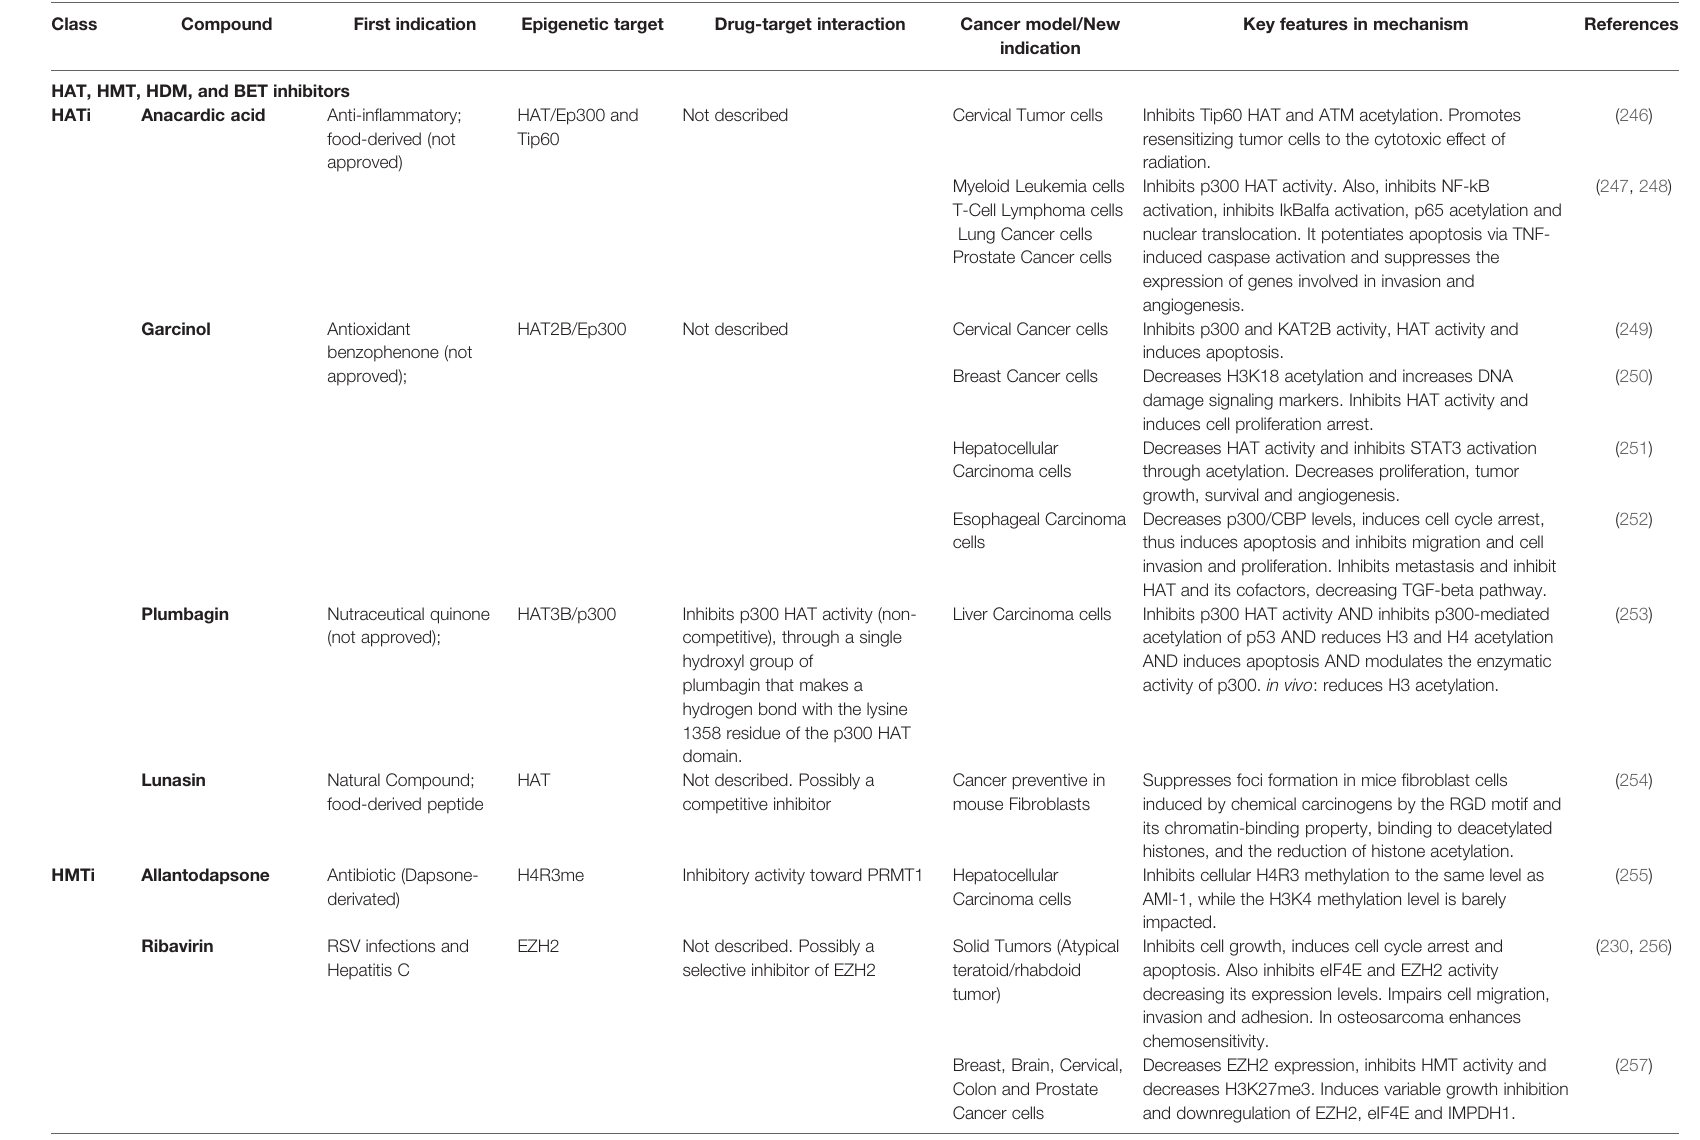
TABLE 6 | Current HAT HMT, HDM, and BET inhibitors repurposed with epigenetic applications in cancer therapy [*modi fi ed from Moreira-Silva et al.,